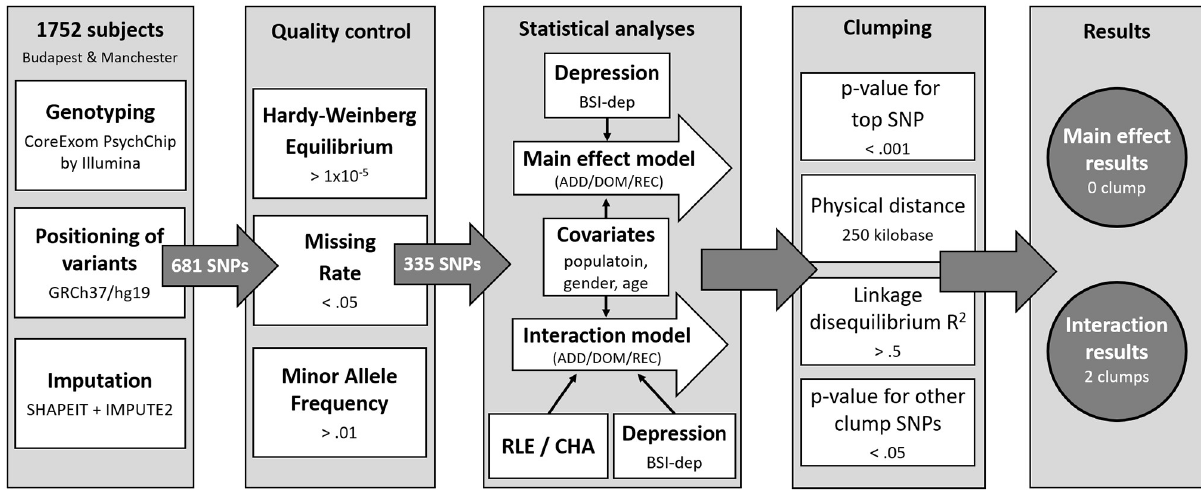
Fig 1. Methods of investigating the effects of variation in P2RX7 in interaction with childhood adversities and recent life events on current depression: Study population, quality control steps and statistical analyses. RLE: recent life events; CHA: Childhood adversities; BSI-Dep–Brief Symptom Inventory depression score; ADD: additive model; DOM: dominant model; REC: recessive model.